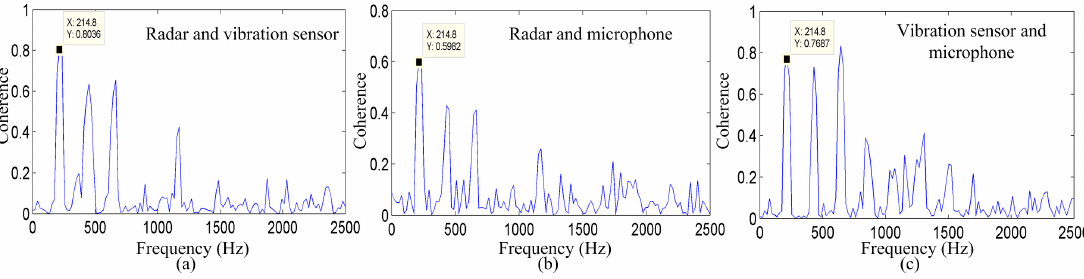
Figure 7. Coherence among the three measurement methods for the vowel sound /a/. Coherence between the signals detected by the ( a ) radar and vibration sensor; ( b ) radar and microphone system, and ( c ) vibration sensor and microphone system.